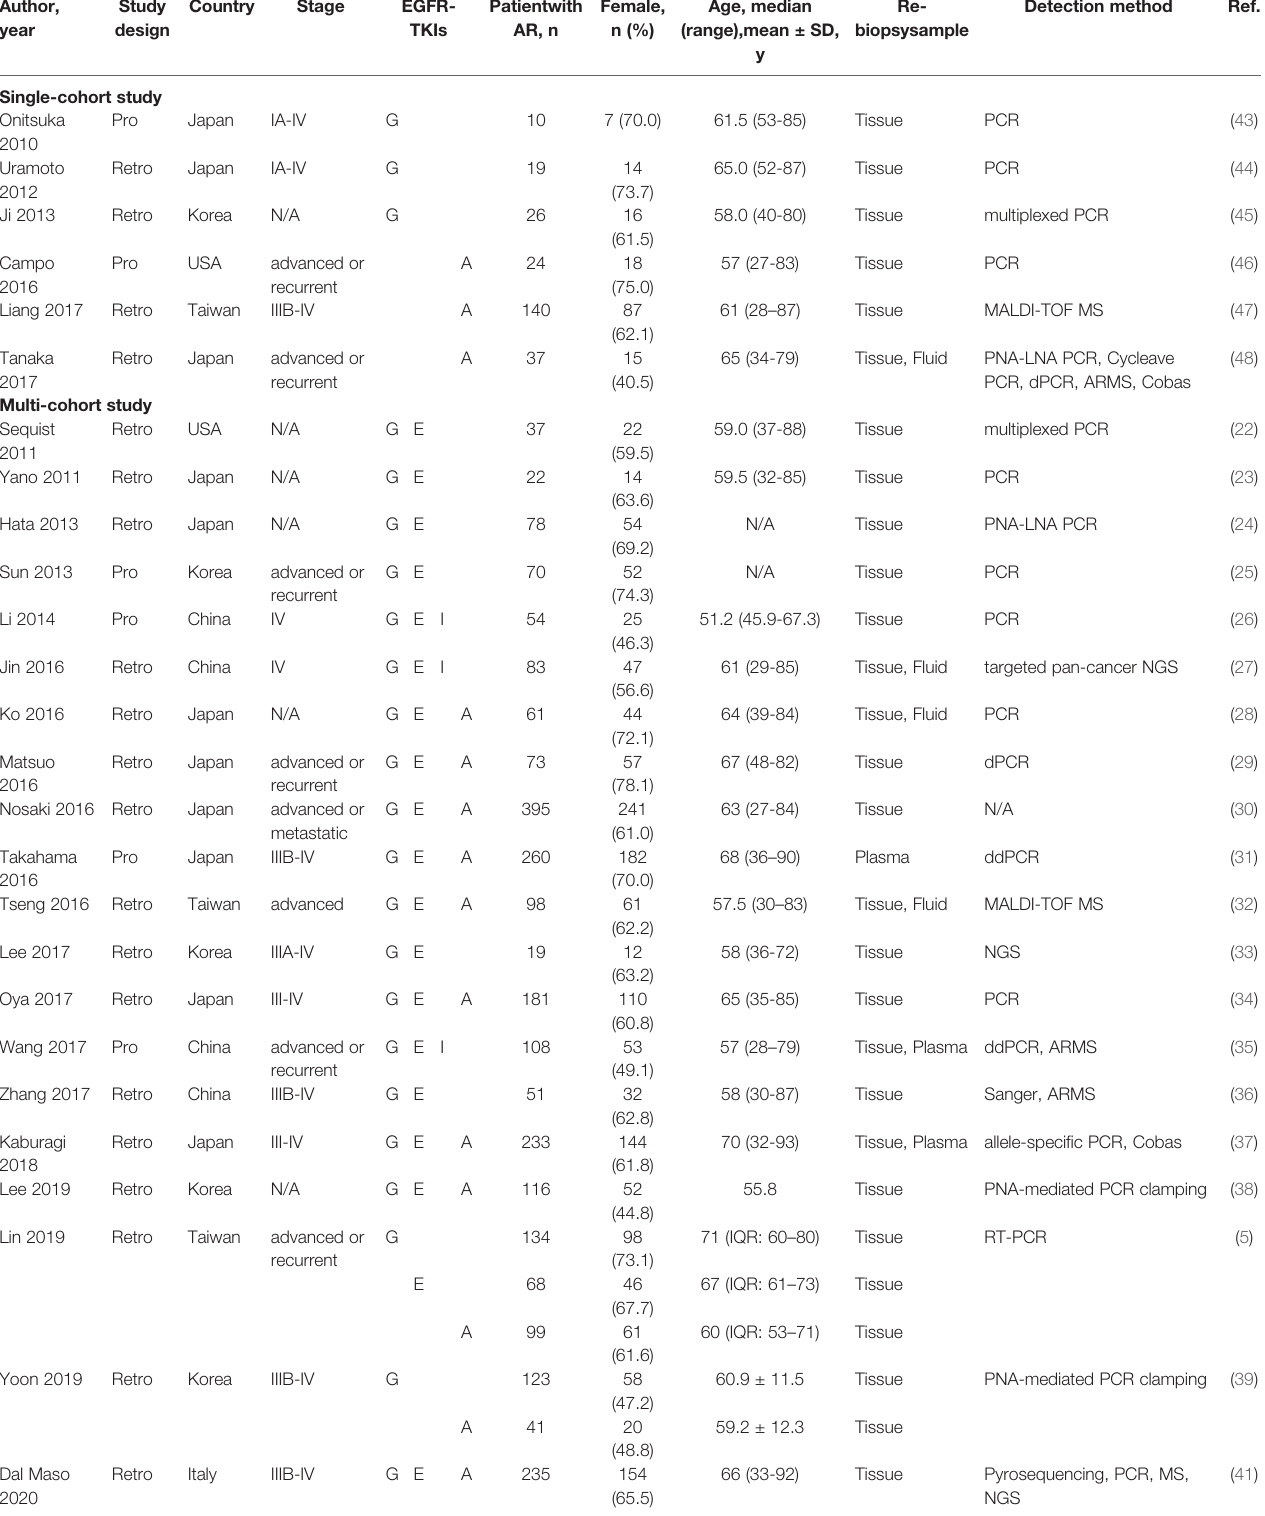
TABLE 1 | Summary of the retrieved